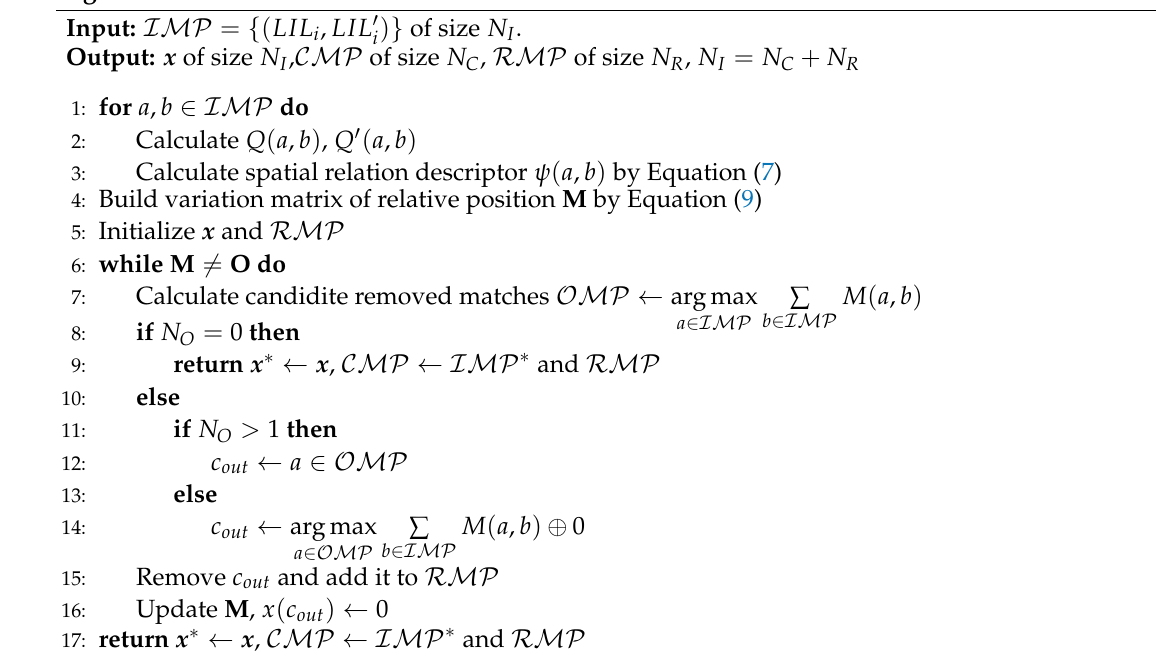
Algorithm 1 LIL Outlier